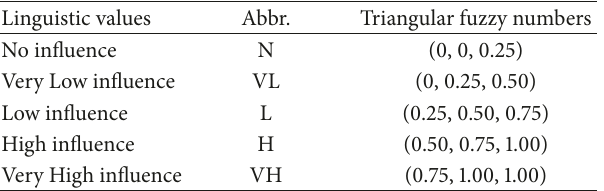
Table 4: The fuzzy linguistic scale for the Fuzzy-DEMATEL analysis.